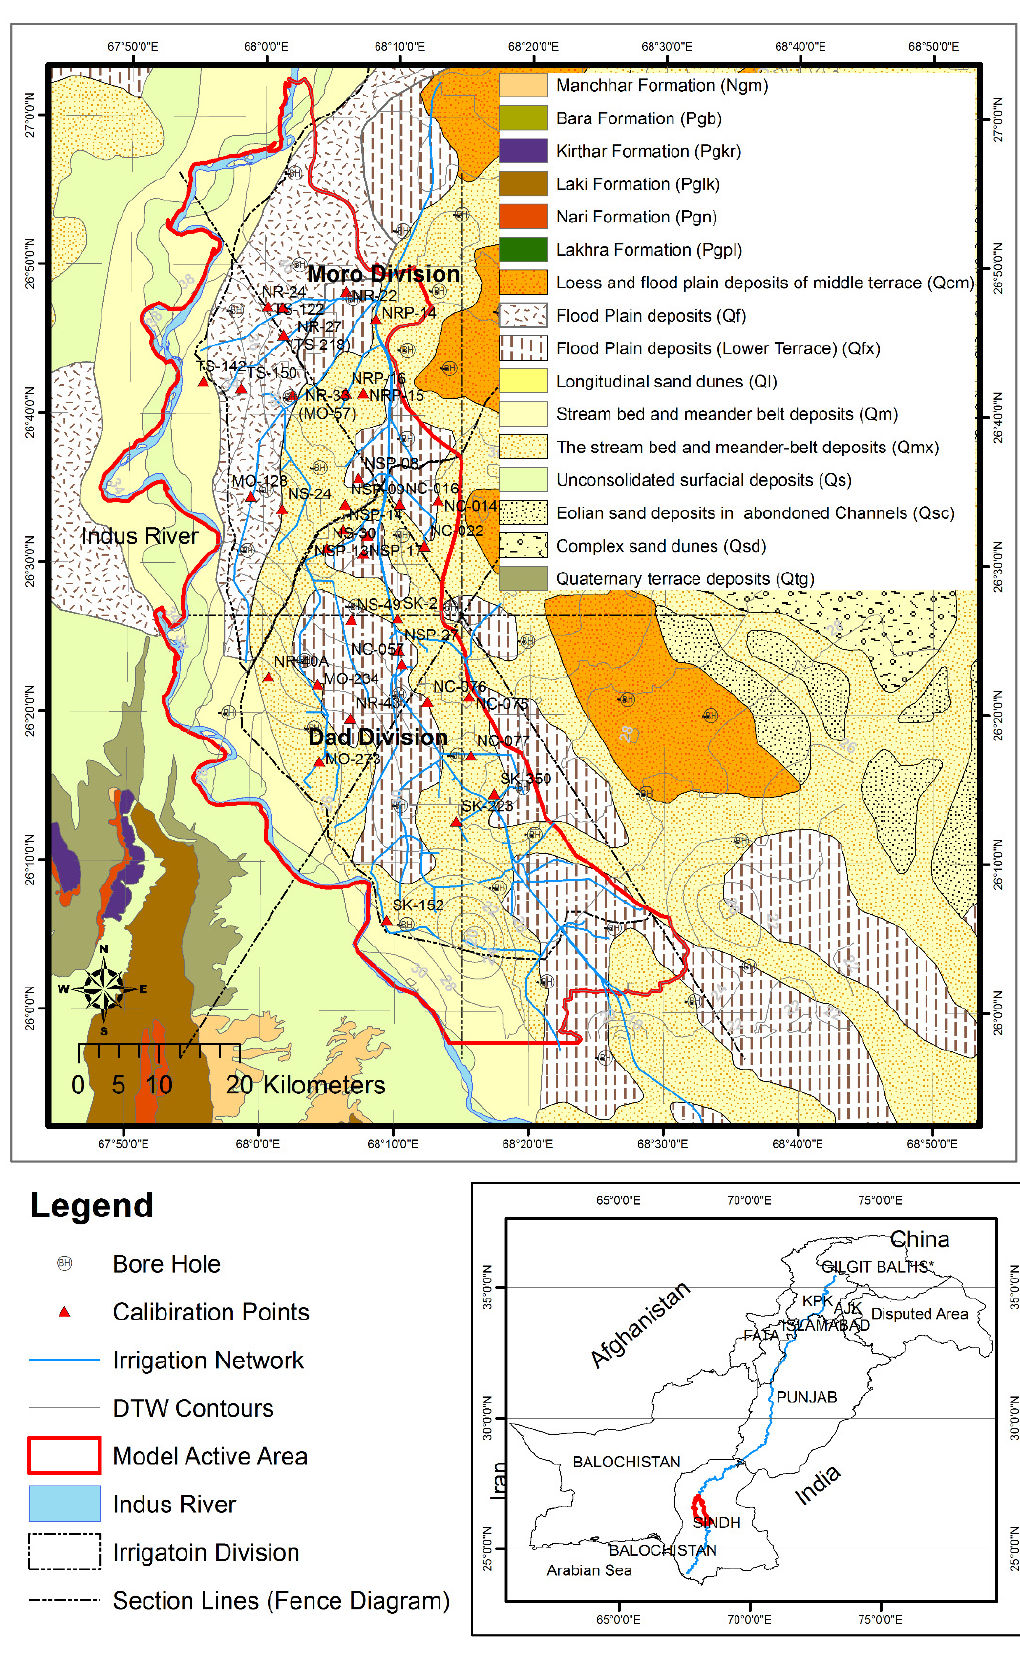
Figure 1. Hydrogeological features in the study area.